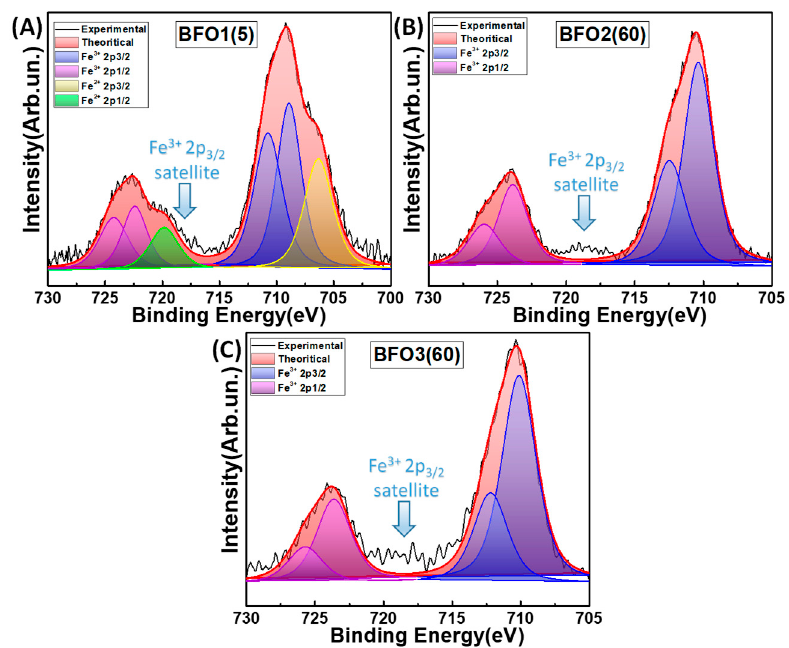
Figure 4. Fe-XPS spectra of ( A ) the BFO1(5), ( B ) BFO2(60), and ( C ) BFO3(60) materials, with the corresponding fitted Fe 3+ 2p3/2, Fe 3+ 2p1/2, and the Fe 2+ 2p3/2, Fe 2+ 2p1/2 peaks.